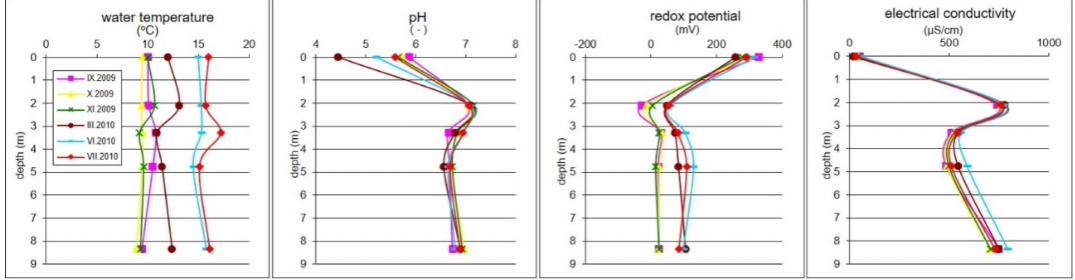
Figure 2. Seasonal variations of physicochemical parameters of groundwater in the Po˙zary aquifer vertical profile. The values for rainwater are shown at depth 0.0